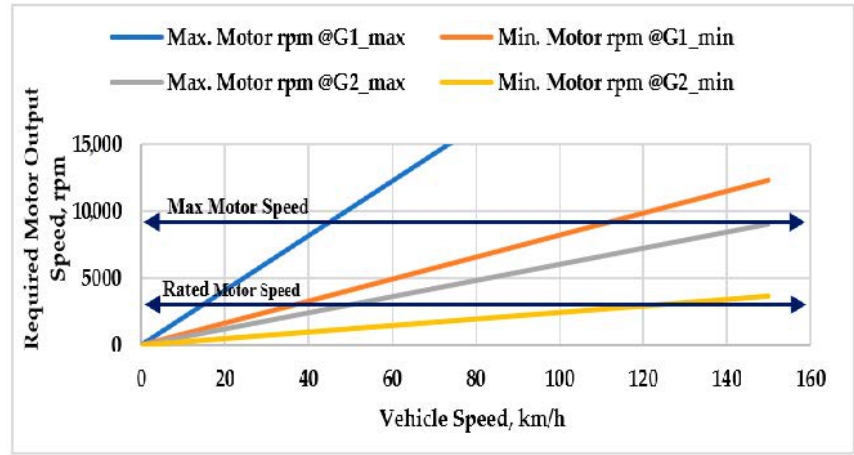
Figure 3. Required motor output speed against desired vehicle speed at the upper and lower bounds of gear 1 and gear 2.